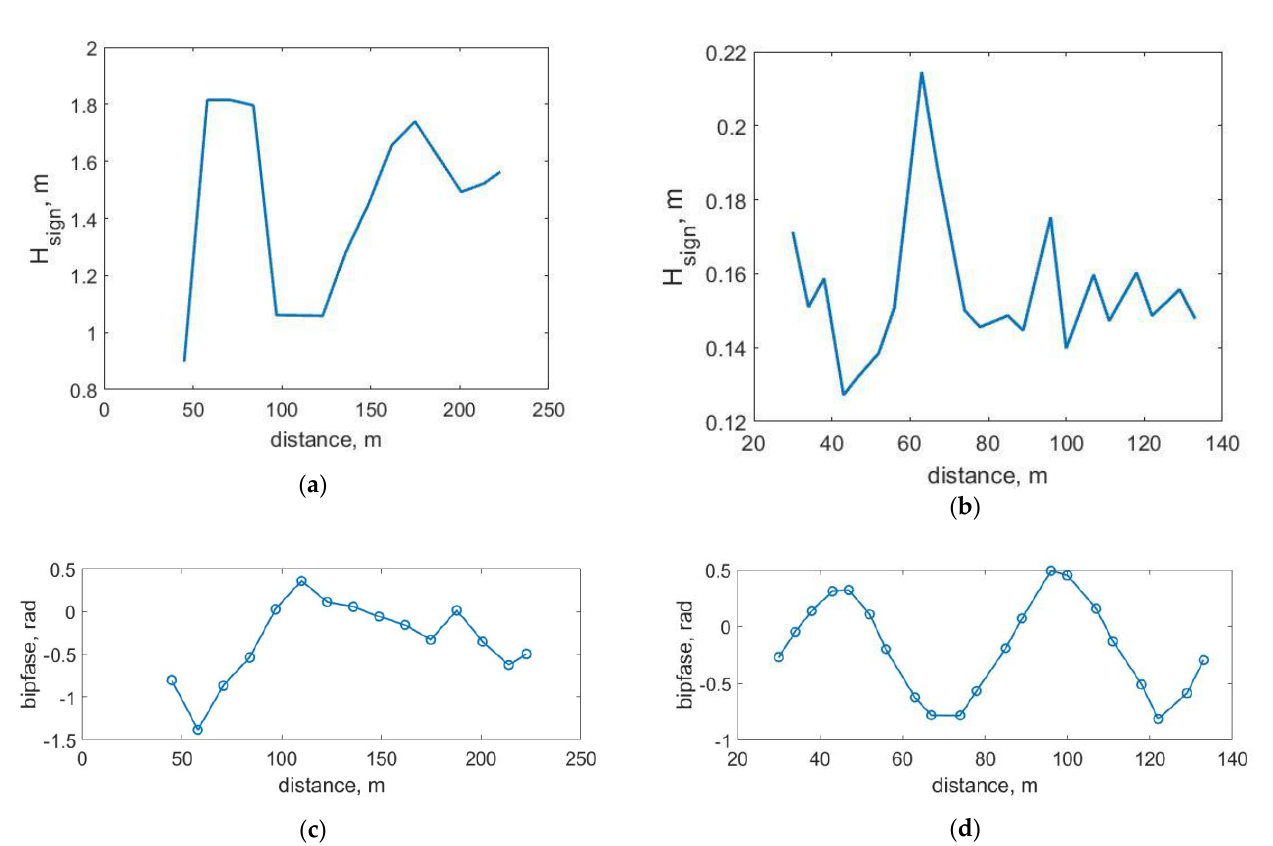
Figure 8. Spatial fluctuations of significant wave heights ( a , b ) and biphase ( c , d ) in field ( a , c ) and laboratory ( b , d ) exper- iments.